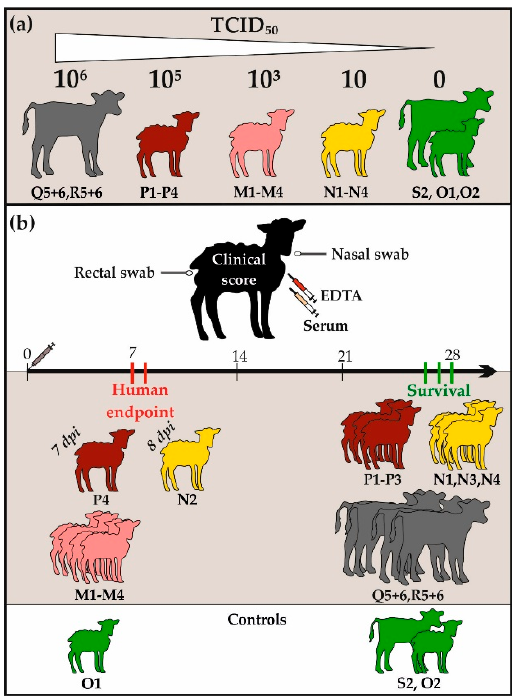
Figure 1. Experimental set-up and clinical outcomes: All animals involved in this study are visualized alongside with the corresponding infection doses in section ( a ). In section ( b ), the collected samples are presented together with the clinical outcomes of all infected animals. Whereas half of the sheep had to be euthanized due to human endpoints, all calves and the other six sheep survived the NSDV challenge.